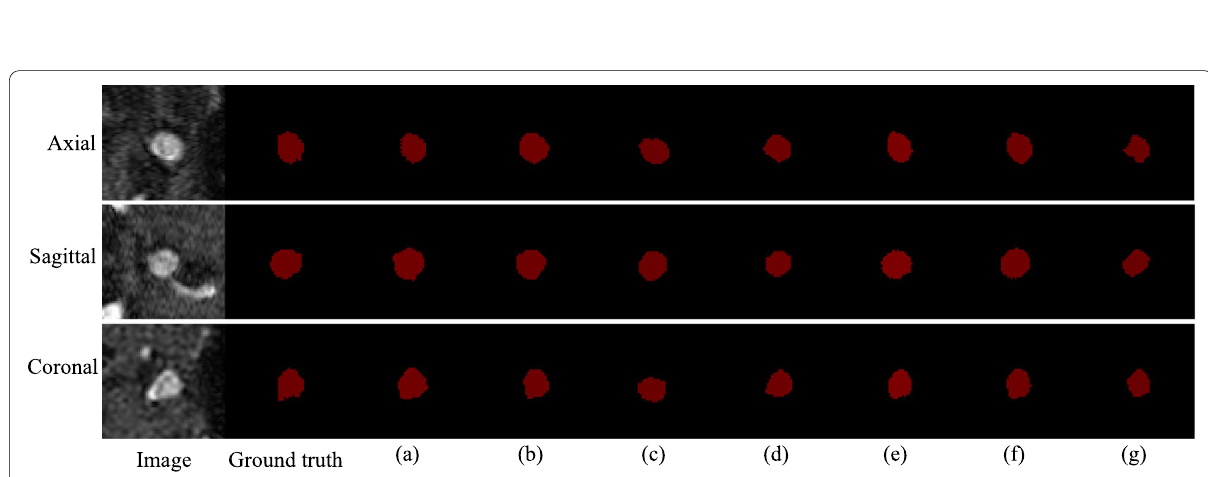
Fig 8 Prediction maps of different models, on the ADAM test set. a The proposed model; b MIP DAResUNet; g 3D